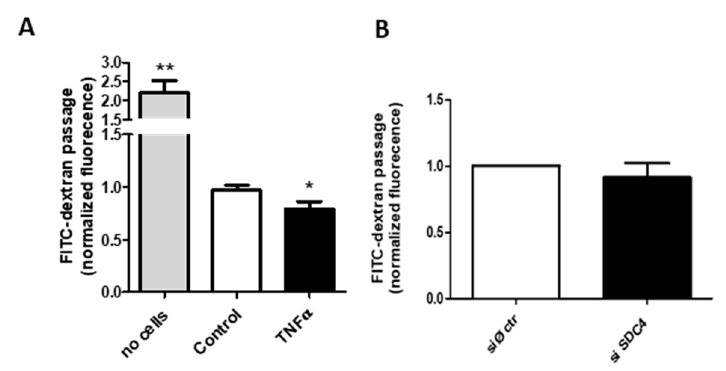
Figure 4. Transwell permeability assay. ( A ) FITC-dextran flow through HUVEC monolayer. Conflu- ent HUVEC cells in the upper chamber of a transwell system +/ − TNF- α were added with 1 mg/mL of dextran conjugated with FITC. After 24 h, the medium of the lower chamber was collected and FITC fluorescence was measured, * p < 0.05 and ** p < 0.01. ( B ). FITC-dextran flow through siRNA control (siØ ctr) or siRNA against SDC4 HUVEC monolayers; data are mean ± S.E.M. and n =